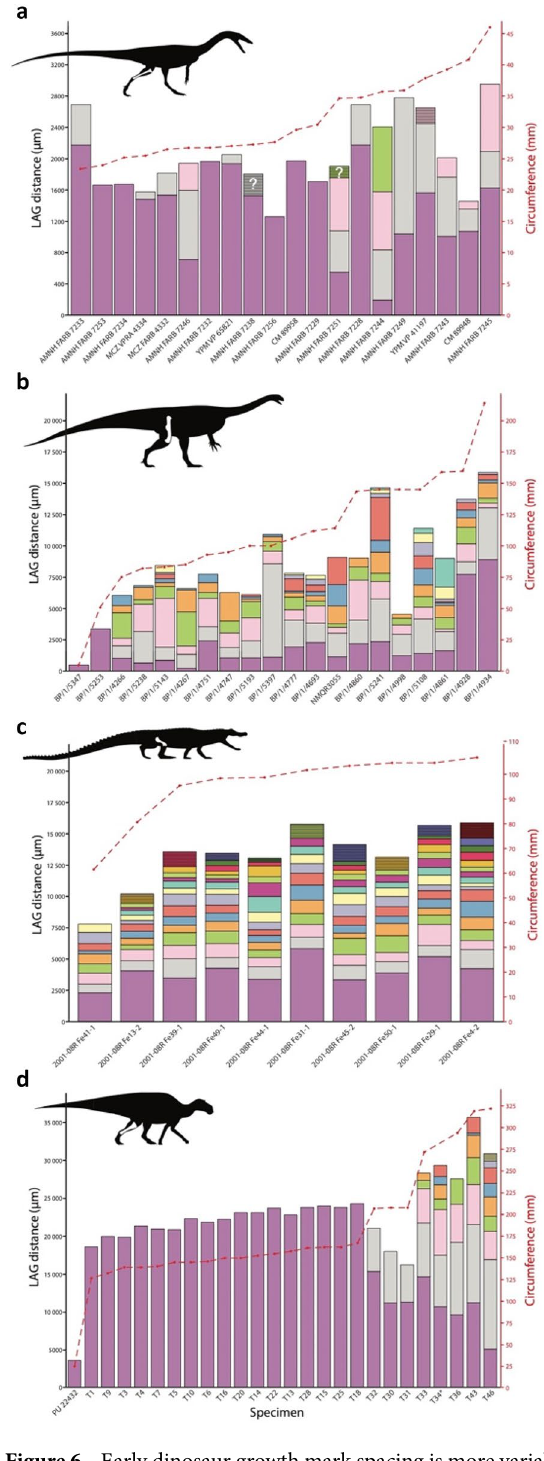
Figure 6. Early dinosaur growth mark spacing is more variable than that of other archosaurs. Growth mark spacing in ( a ) Coelophysis bauri , ( b ) Massospondylus carinatus , reprinted from ref. 14 with permission of the authors, ( c ) Alligator mississippiensis , and ( d ) Maiasaura peeblesorum . Outer circumferential layers (OCLs) or external fundamental systems (EFSs) are indicated with closely spaced lines in the outermost growth zone. Skeletal drawings/silhouettes provided courtesy of Scott Hartman (www. skele taldr awing. com), who retains ownership of these